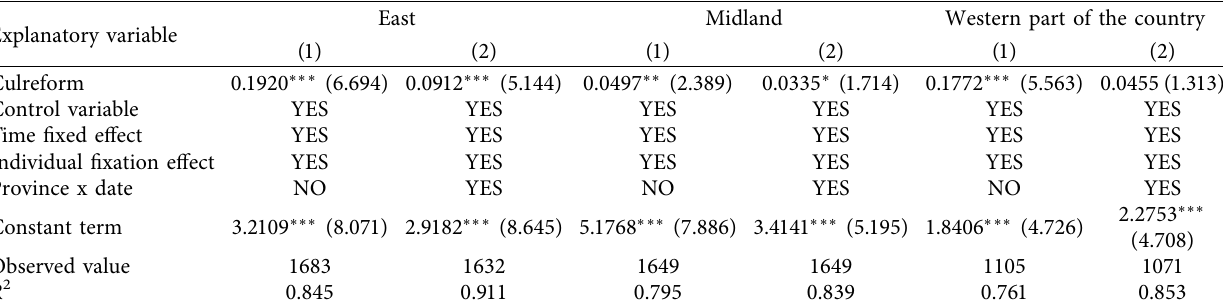
Table 8: Heterogeneity regression